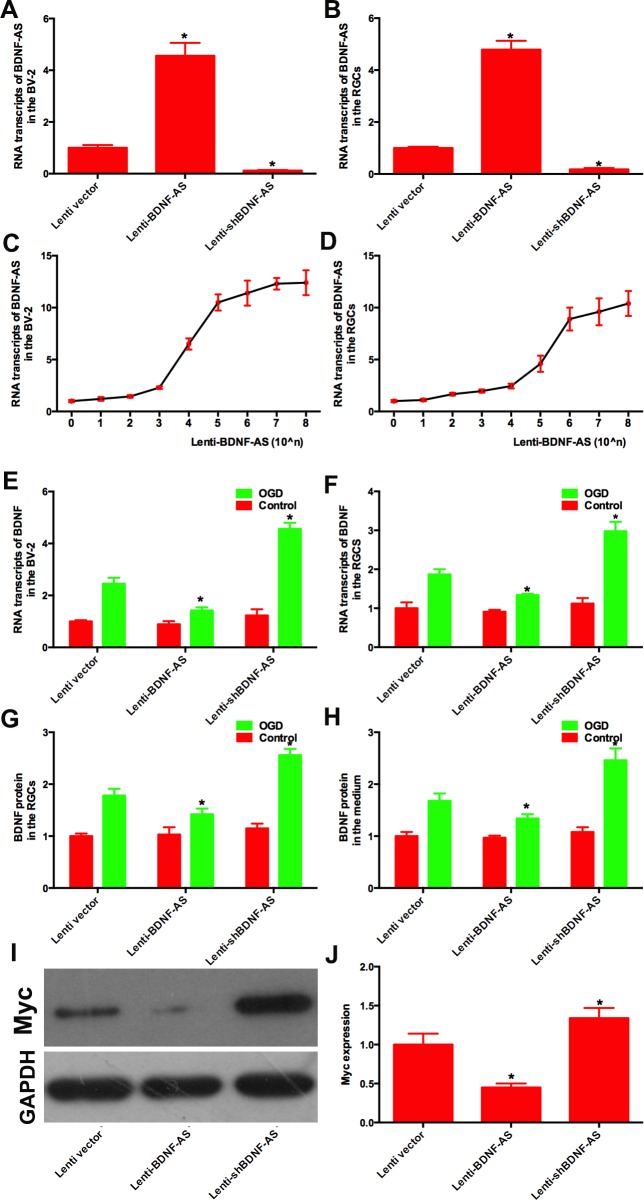
BDNF-AS reduced the expression of BDNF.(A) In BV-2 cells and (B) RGCs, lenti-BDNF-AS increased the level of BDNF-AS while the lenti-shBDNF-AS reduced the level of BDNF-AS. Lenti-BDNF-AS increased the levels of BDNF-AS in the dose-dependent manner in BV-2 cells (C) and RGCs (D). (E) In BV-2 cells under normal conditions, BDNF mRNA levels were not significantly changed by either lenti-BDNF-AS or lenti-shBDNF-AS while under OGD conditions, BDNF mRNA levels were decreased by lenti-BDNF-AS and increased by lenti-shBDNF-AS. (F) In normal RGCs, BDNF mRNA levels were also unchanged by either lenti-BDNF-AS or lenti-shBDNF-AS. When RGCs were subjected to 6 h of ischemia, BDNF mRNA levels were decreased by lenti-BDNF-AS and increased by lenti-shBDNF-AS. The total protein was derived from (H) RGCs and (I) the culture medium. The BDNF protein was measured by ELISA and showed a similar trend as observed with mRNA expression. (J) The BV-2 cell line expressing Myc-tagged BDNF. Lenti-BDNF-AS reduced Myc expression while lenti-shBDNF-AS increased this expression. (K) represents the summarized data of the western blots. P<0.05 was considered significantly different; * vs control group.